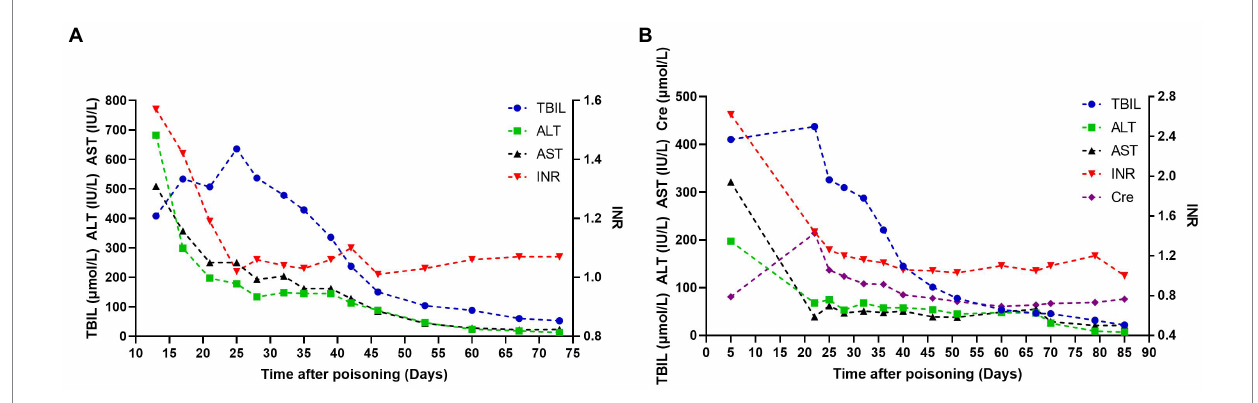
FIGURE 1 Dynamic trends of the main biochemical indexes of patients. (A) Represents case 1, (B) represents case